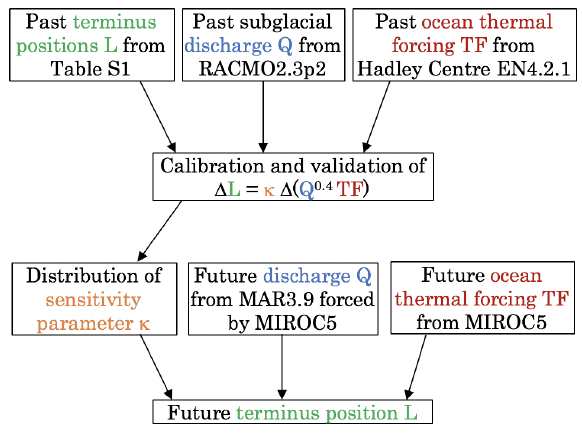
Figure 1. Schematic of approach taken in this study. We use ob- servations and reconstructions of past terminus position, subglacial discharge and ocean temperature to calibrate and validate a simple parameterization for tidewater glacier retreat. We use the resulting parameterization, together with projections of future subglacial dis- charge and ocean temperature, to project future terminus